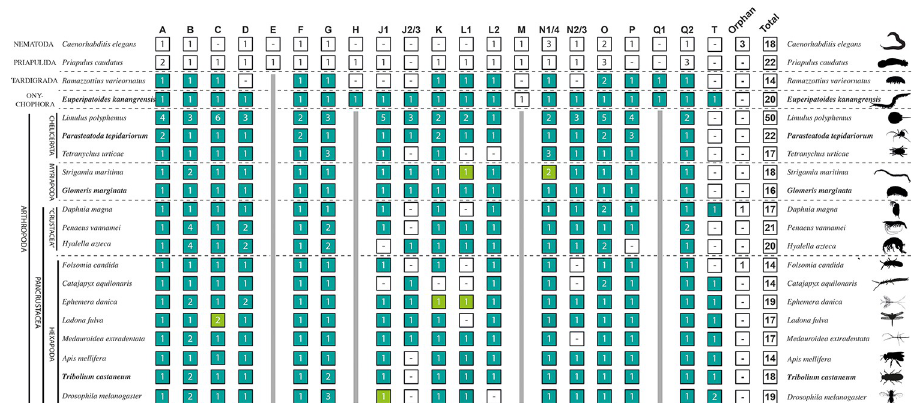
Fig 1. The complement of ecdysozoan Fox genes. Modified after [28] (their Fig 2). Green and light green boxes indicate that the gene falls in a given class of Fox genes in all or two of three analyses conducted in [28], respectively. Roman numbers in boxes indicate numbers of paralogs. A dash (-) indicates a predicted loss of a given lineage-specific Fox class gene. Solid vertical grey bars suggest losses of a class of Fox genes. Data on Apis mellifera stem partially from [198]. Note that the lack of FoxJ23 in holometabolous insects in this overview does not represent a general loss in this group of animals (as it is present and some species), and that a possible FoxQ1 gene was identified in a scorpion, albeit with weaker support [28]. A recent report by [62] listed 21 Tribolium Fox genes, but note that this is because three and two identical sequences of FoxO and FoxP respectively were incorporated in their list [62] (their Fig 2). The same analysis lists two Drosophila FoxP genes which appears to be a typo in their